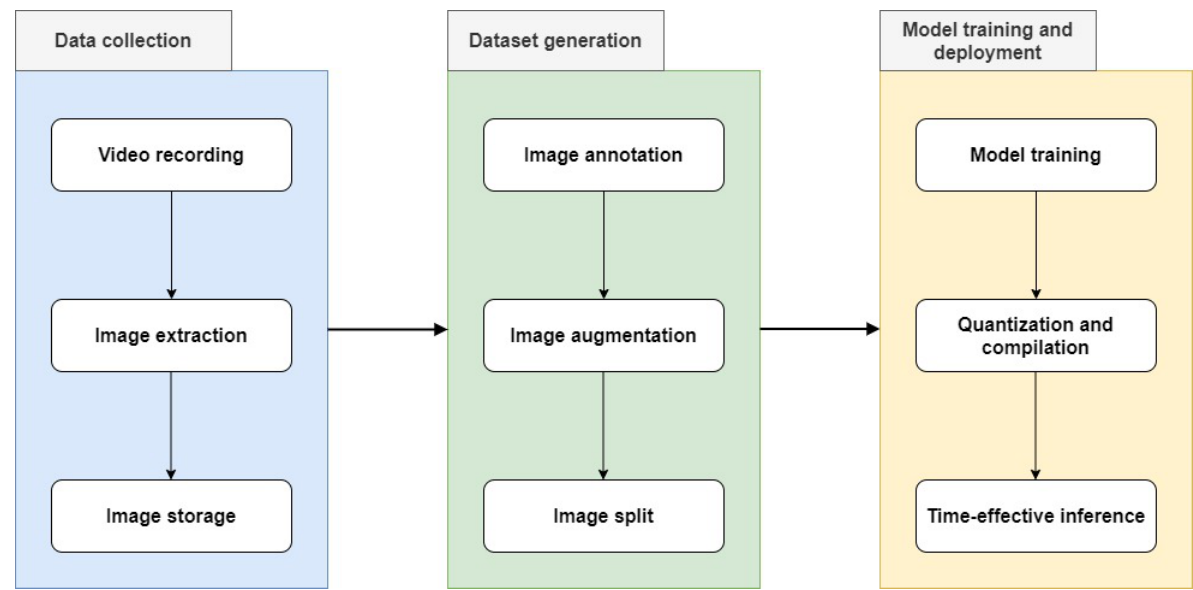
Figure 2. High-level workflow of the proposed system. The first step is data collection, where images are extracted and stored from videos recorded by onboard cameras. Then, the dataset is generated by the grape bunch annotation; data augmentation is performed to increase the dataset size; the images are split to improve the training performance. Finally, the models are trained, then quantized and compiled so that they can be deployed in a lightweight embedded